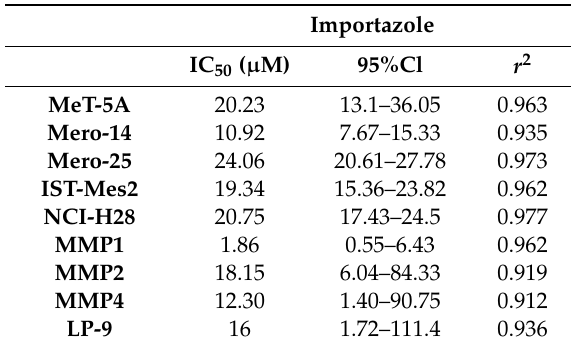
nonlinear Table 1. IC 50 of importazole (IPZ) in Met-5A and MPM cells. All values are in μ M. The calculated IC 50